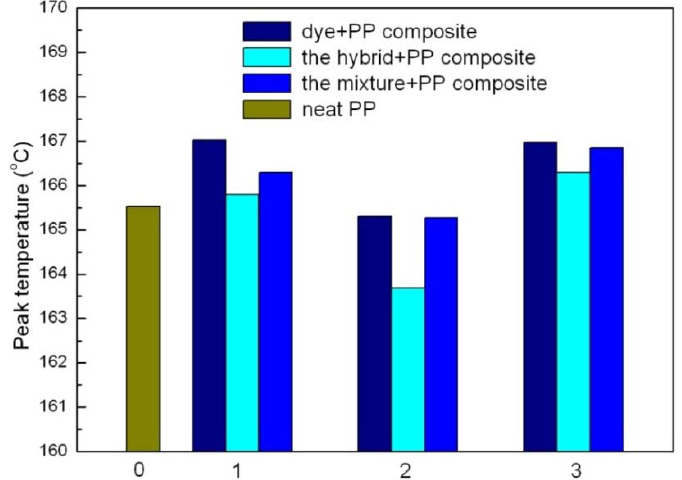
Figure 17. Temperature of different filler compositions in PP. 0 for neat PP, 1 for APRB related PP composites; 2 for MB related PP composites; 3 for ABB6B related PP